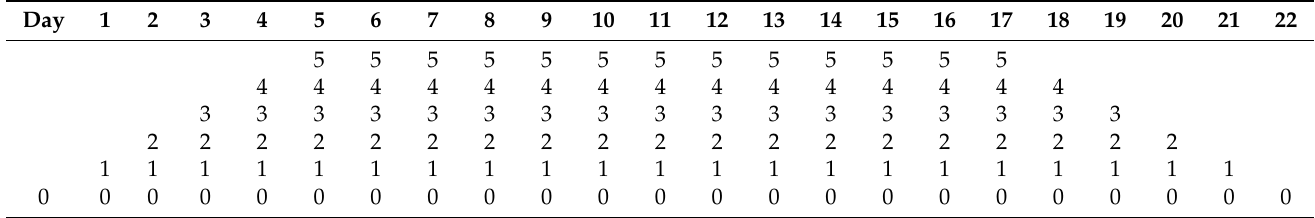
Table 2. State Space of Dynamic Programming.